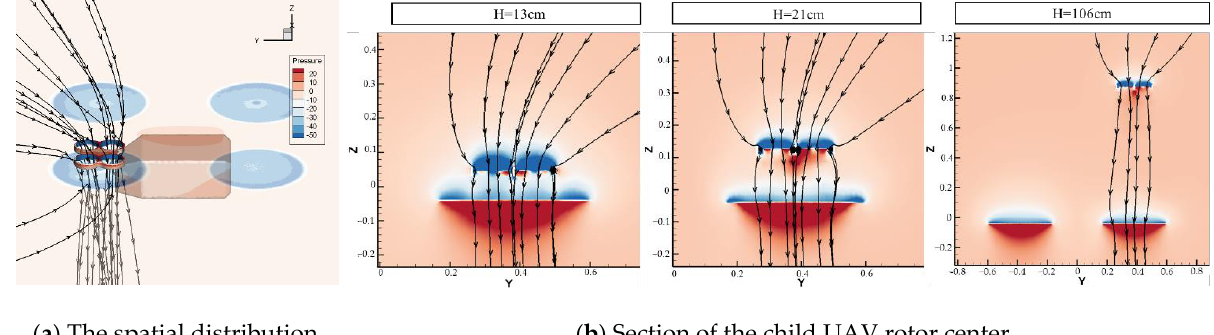
Figure 22. Flow field figure when the child UAV is right above the parent UAV rotor. As the child UAV moves to the outside in body-outside transition area, the wake also gradually moves to the outside. The wake has been fully developed in the hovering state. The change in pressure distribution under the child UAV during the movement of the child UAV is shown in Figure 23. On the one hand, the body effect of parent UAV is obviously weakened. The airflow passing through the child UAV propellers is more likely to bypass the body of the parent UAV and flow downward, so that the pressure below is reduced. On the other hand, the “downwash effect” caused by parent UAV rotors is strengthened. The increase in the downward velocity above the child UAV not only increases the pressure on the upper surface, but it also causes the induced power of child UAV rotors to gradually become larger. The reduced “body effect” and the increased “rotor effect” lead to a continuous lift reduction of the child UAV. Paz’s research on the process of UAV flying over obstacles has similar conclusions, pointing out that this process has a considerable impact on the flight stability [18].